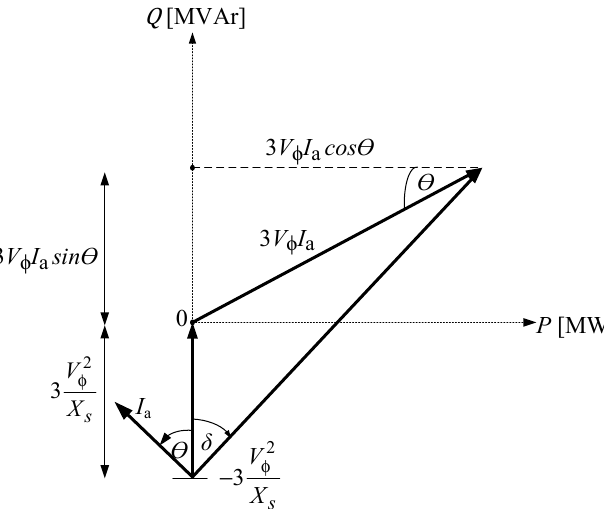
Figure 5. Phasor diagram in Figure 4 after reflecting on the y -axis.